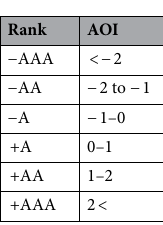
Table 7. Categorical rank from the continuous data of AOI.